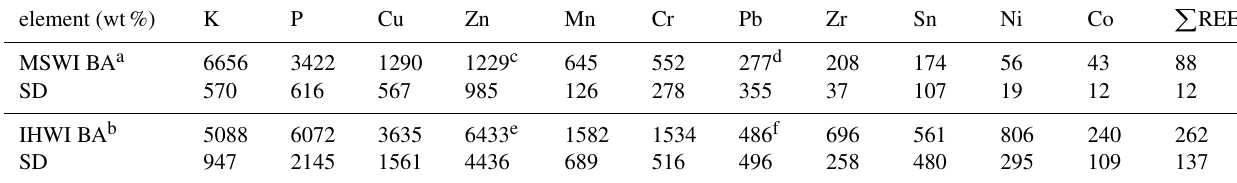
Table 2. Averaged content of minor elements in BAs from waste incineration. element (wt%) K